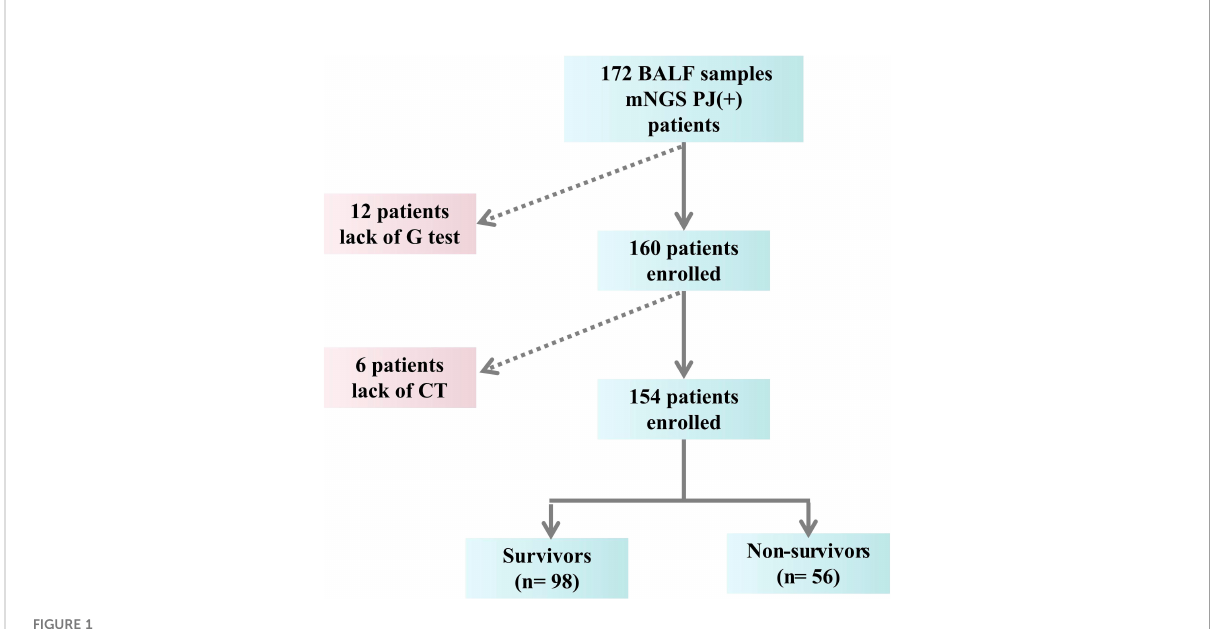
FIGURE 1 The fl ow